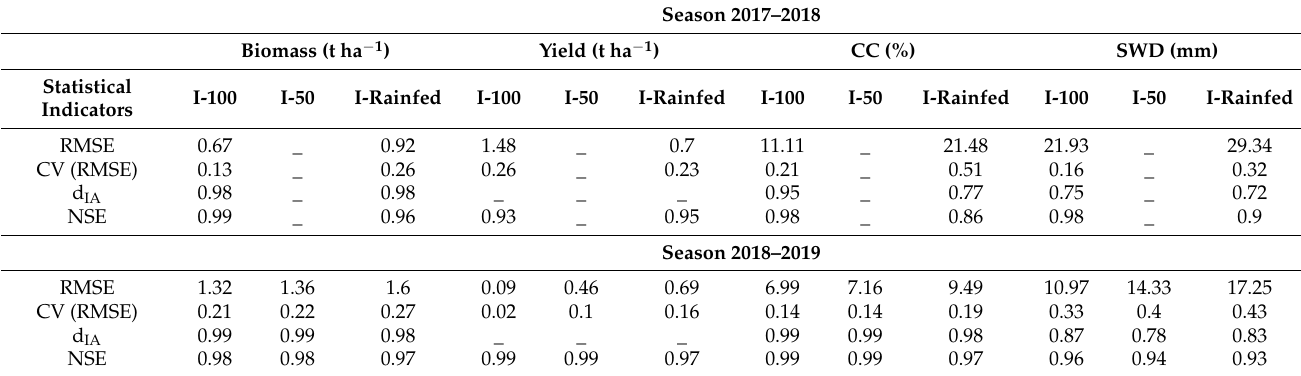
Table 7. Statistical indices derived for evaluating the performance of the AquaCrop model in simulating biomass,